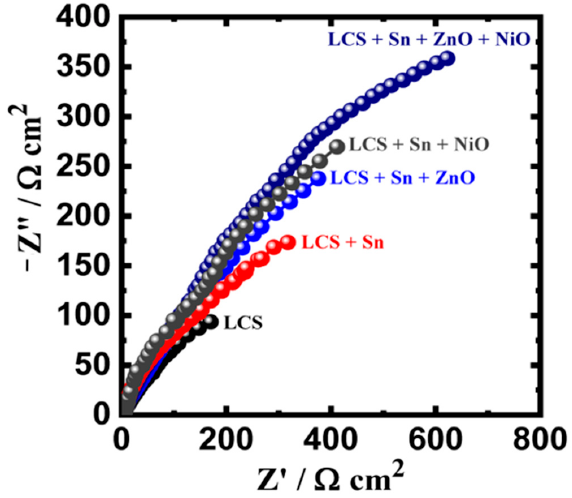
Figure 7. Nyquist graph for LCS, LCS + Sn, LCS + Sn + ZnO, LCS + Sn + NiO, and LCS + Sn + ZnO + NiO specimens following 1 h dipping in 3.5% NaCl medium. Reprinted with permission from Ref. [45] MDPI (2022). Table 1. Summary of some recently investigated nano-modified/nanomaterial-based corrosion inhibitors/coatings for several metals in various corrosive